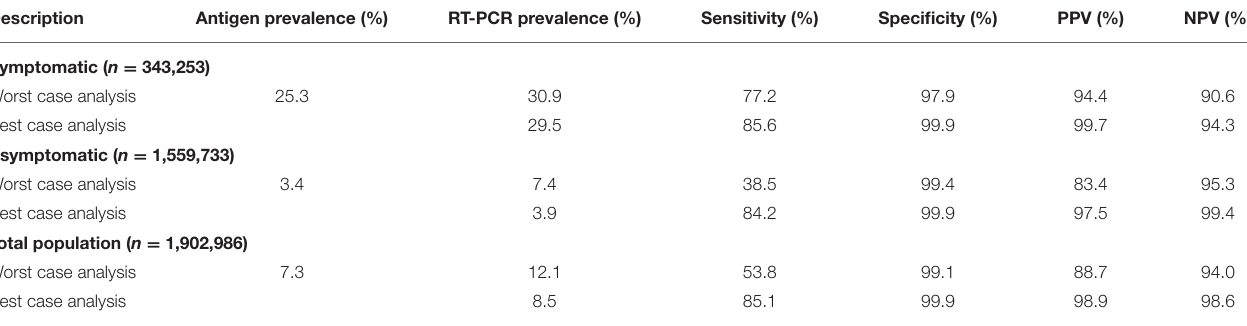
TABLE 2 | Antigen test diagnostic performance under different assumptions for the specimens without paired RT-PCR results.